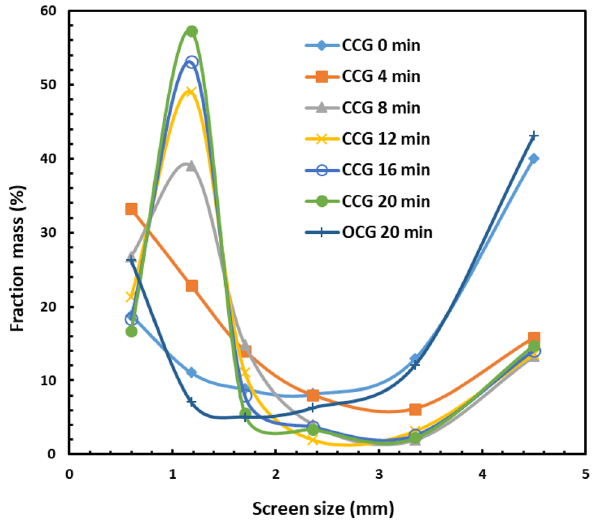
Figure 3. Particle size distributions as a function of grinding time (CCG is the closed-circuit grinding and OCG is the open circuit grinding).